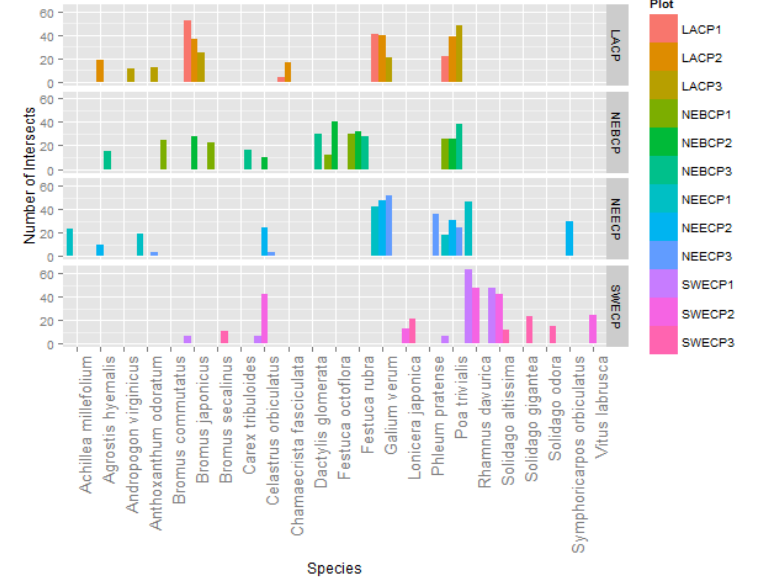
Figure 5. Species composition from vegetation surveys of community plots (CP) at Blandy Experimental Farm in northern Virginia at Lake Arnold (LA), the boundary near the northwest successional field (NEB), the northeast early successional seres (NEE), and the southwest early successional seres (SWE), where the y -axis represents the number of intersects (out of the total 121 intersects surveyed in each plot) at which certain species were